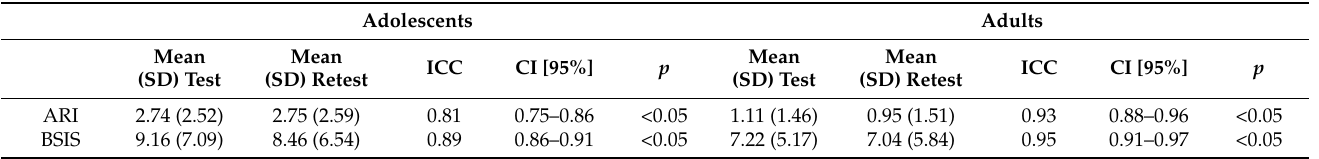
Table 5. Intraclass correlation coefficients for test–retest reliability of the ARI and BSIS scales in the adolescent and adult population.